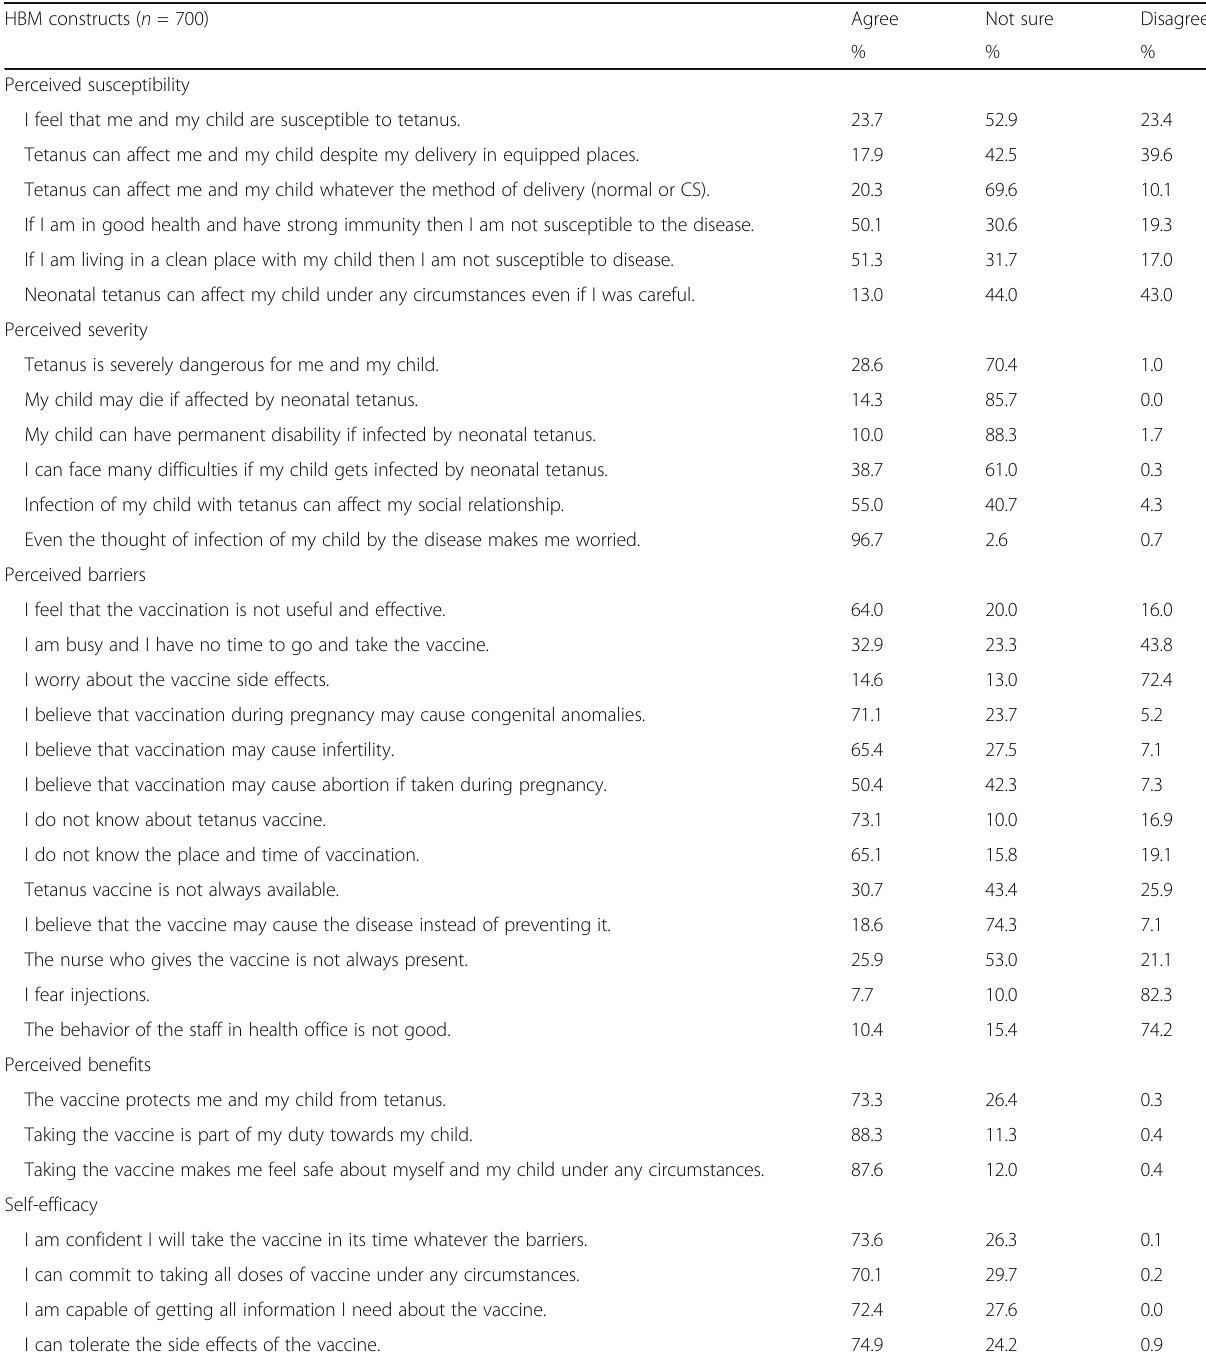
Table 3 Responses of reproductive-age women in Alexandria to the different belief items of the HBM, 2018 HBM constructs ( n = 700) Agree Not